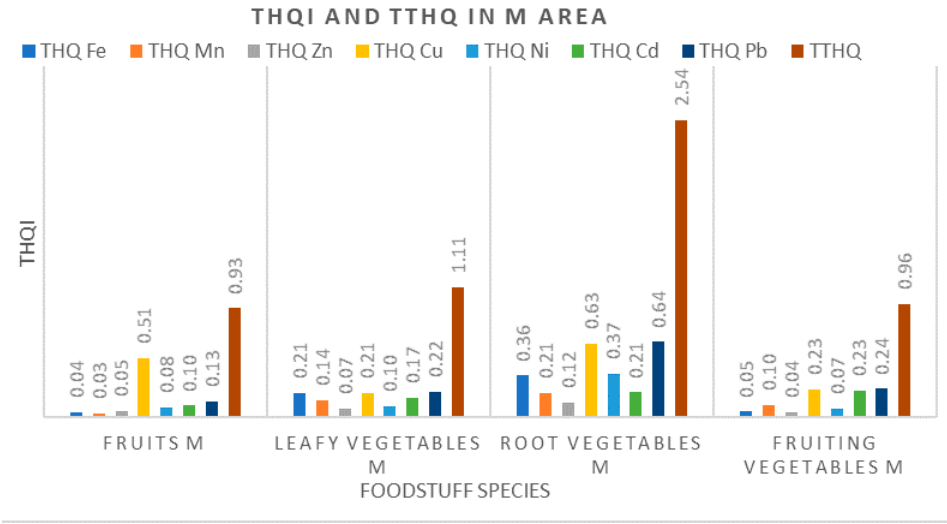
Figure 5. Measured values for THQi and TTHQ in the Moldova Veche (M) area. Int. J. Environ. Res. Public Health 2020 , 17 , x